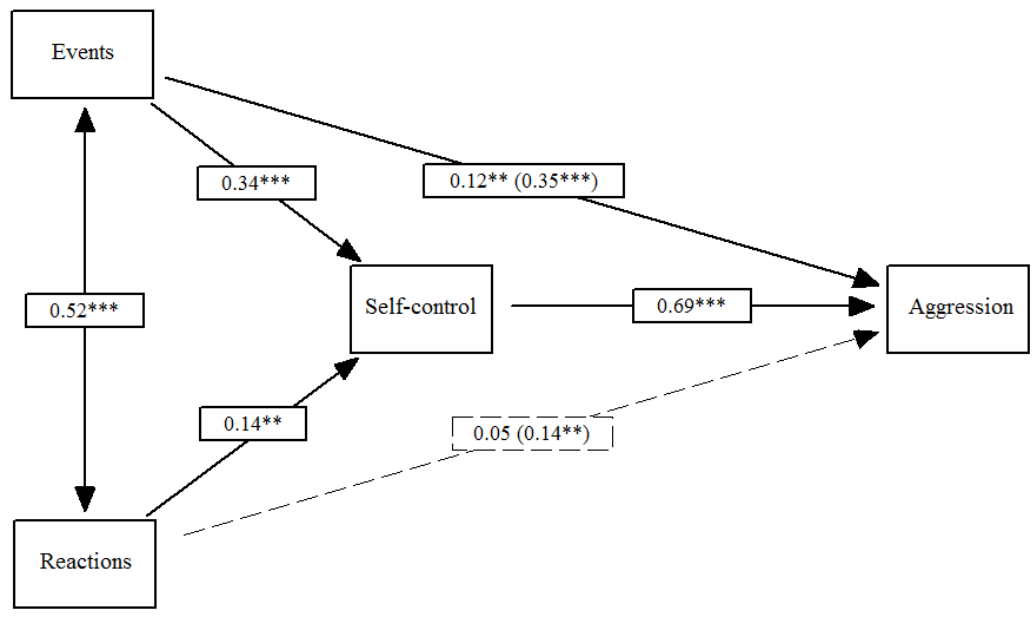
Figure 4. Effects of traumatic events and reactions on proactive, overt aggression mediated by low self-control. Note: Total effects are included in parentheses; ** p ≤ 0.01, *** p ≤ 0.001.